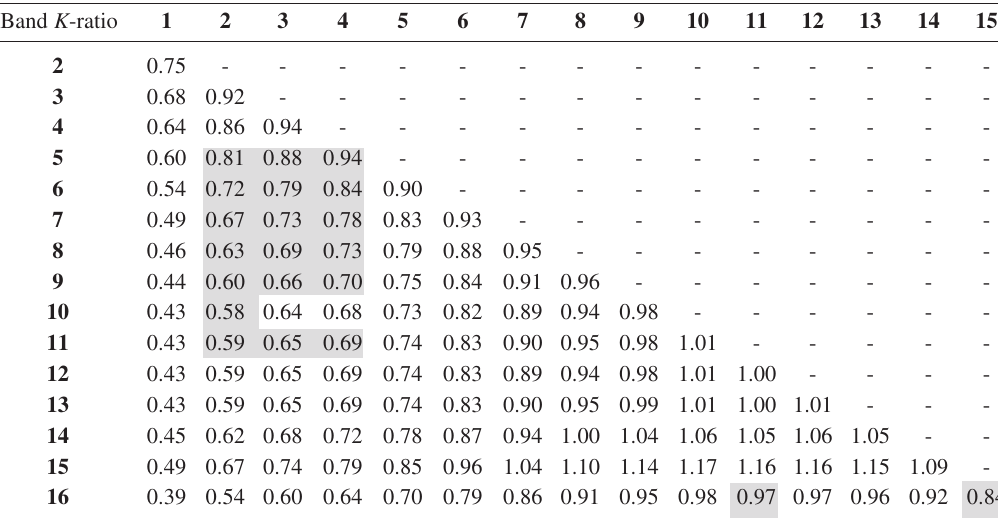
Table I. Diffuse attenuation coefficient ratios. Band K -ratio